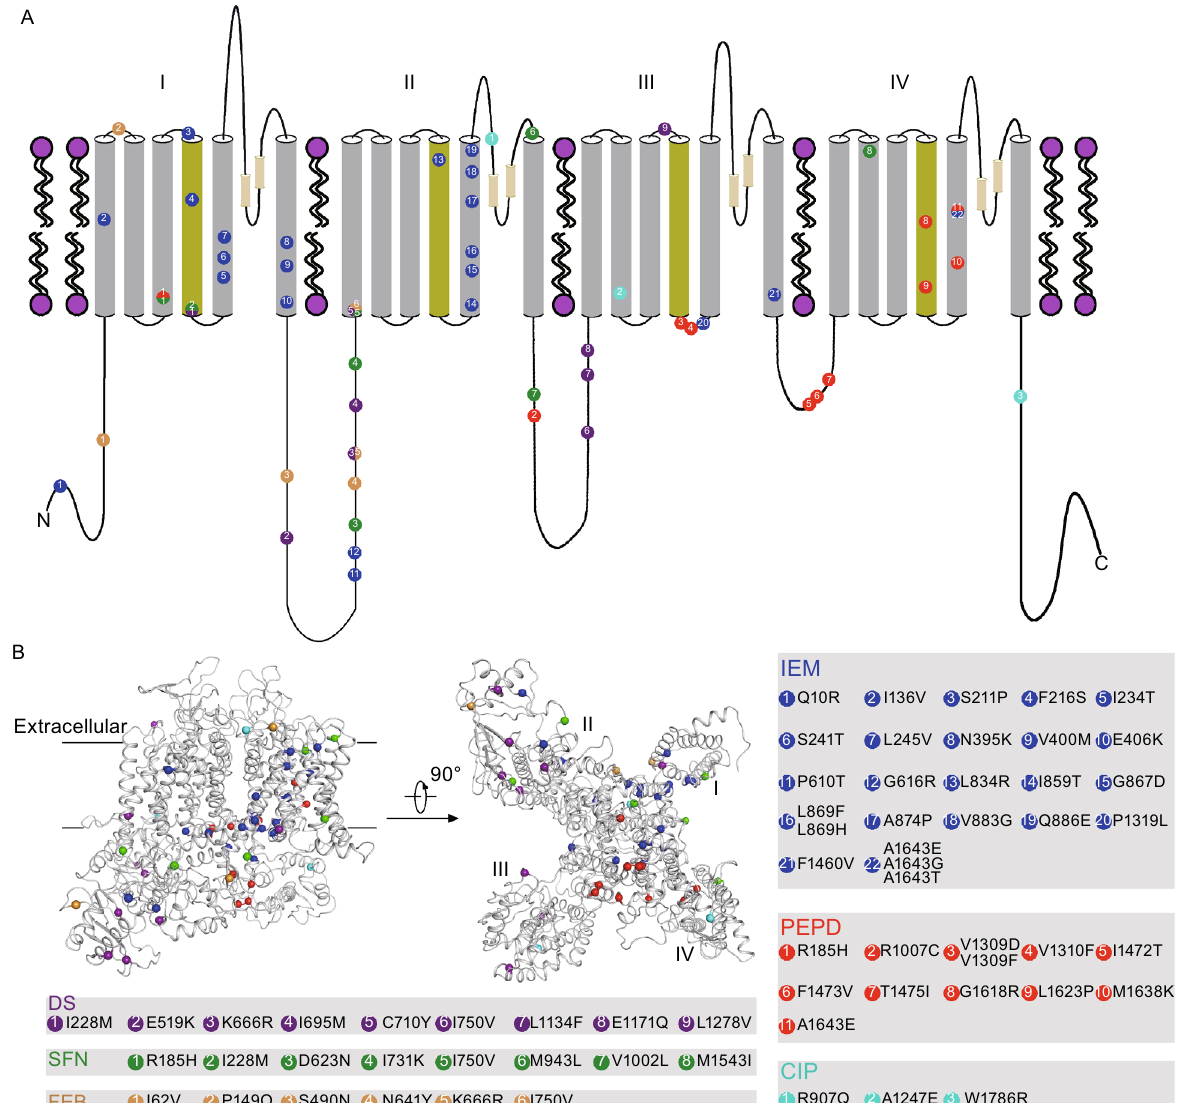
Figure 2. Amino acid locations of Na v 1.7 disease-related mutations on the Na v 1.7 structure model. (A) The topology of human Na v 1.7 sodium channel. Cylinders represent the transmembrane segments, which are colored in gray except that the S4 voltage- sensing segments are colored in yellow. The lines represent the soluble regions between the transmembrane segments or the N/C- terminus. The two P helices between S5 and S6 segments are shown in cylinders. Mutations of Na v 1.7 are discriminately mapped on the topology scheme of Na v 1.7 by different colors, namely, IEM (blue), PEPD (red), CIP (cyan), DS (purple), SFN (green), and FEB (pink). (B) Intra-membrane view and intracellular views of the Na v 1.7 structure model. Mapping of disease-related mutations onto the Na v 1.7 structure model is highlighted by different colors. Summary of Na v 1.7 mutations is shown in different gray